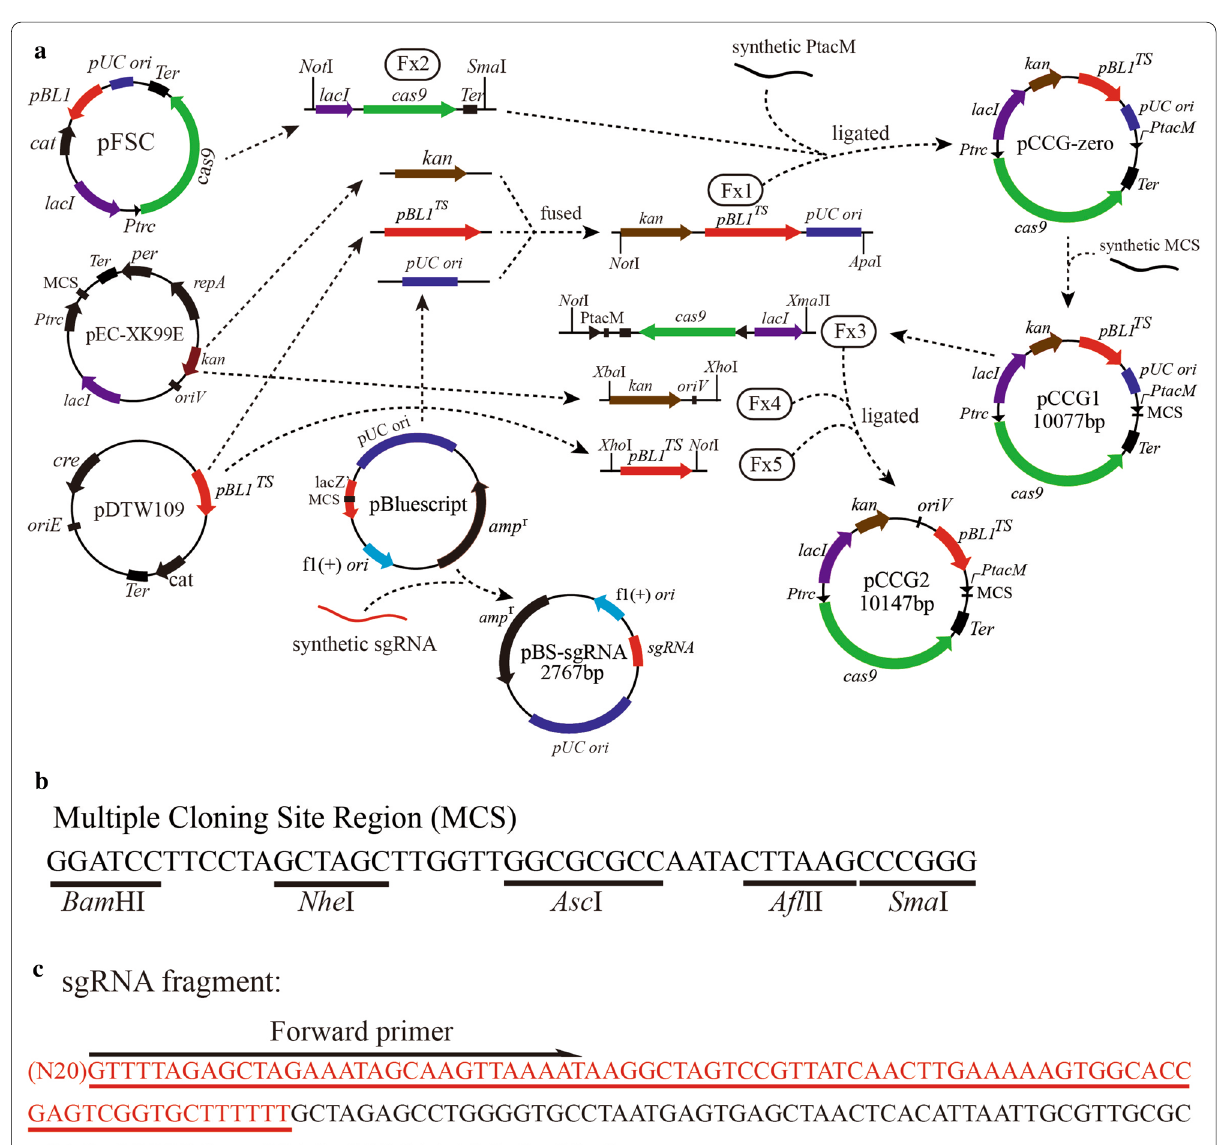
Fig. 1 Construction of CRISPR/Cas9-assisted system. a The overview diagram of vectors pCCG1, pCCG2 and pBS-sgRNA construction, E. coli — C. glutamicum shuttle expression vector pCCG1 and pCCG2 is kanamycin resistance, Cas9 nuclease gene is under the control of the inducible promoter P trc , pBL1 TS is temperature-sensitive replicon in C. glutamicum , constitutive promoter PtacM and multiple cloning site (MCS) were artificial synthesis, sgRNA were expressed by promoter PtacM. Small sgRNA sequence was ligated with plasmid pBluescript II SK. sgRNA fragment were amplified from the plasmid pBS-sgRNA when needed. b The sequence of multiple cloning sites, including Bam HI, Nhe I, Asc I, Afl II and Sma I ( Xma I) restriction enzyme sites. c The full nucleotide sequence of sgRNA fragment (171 bp) in plasmid pBS-sgRNA, the red part is Cas9